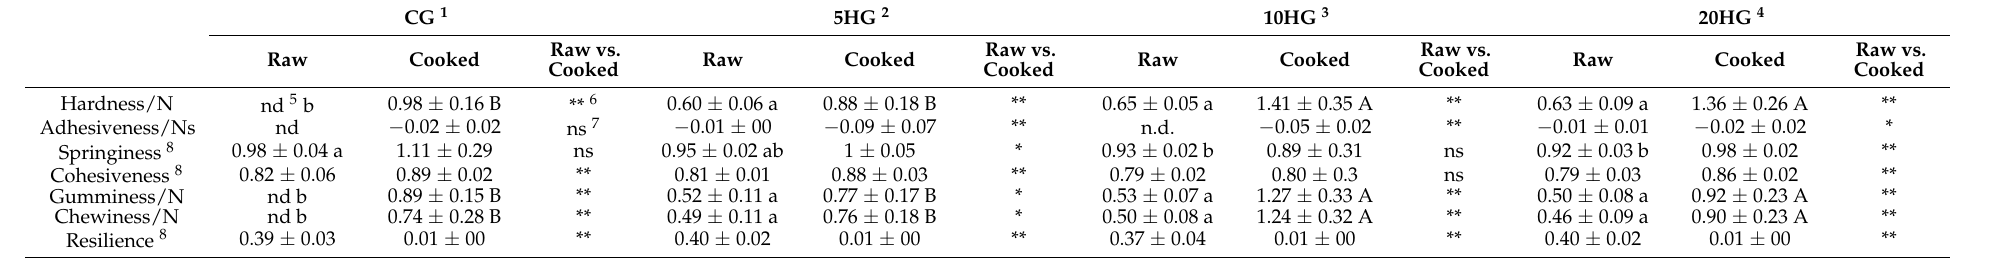
Table 6. Texture parameters of control and hemp seed flour-enriched gnocchi